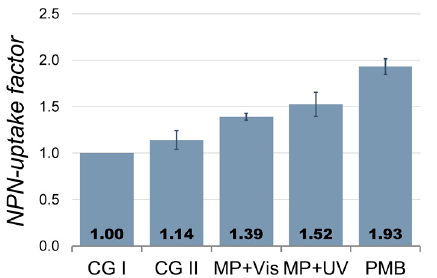
Figure 7. Effects of light and C-TiO 2 +Ni MP powder on S. Typhimurium outer membrane permeability. Two control groups represent data for S. Typhimurium bacteria which were maintained in the dark without (CG I) and with (CG II) C-TiO 2 +Ni MP powder, respectively. MP+Vis and MP+UV samples correspondingly show measures obtained with C-TiO 2 +Ni MP powder and Vis or UV light. PMB samples (bacteria treated by polymyxin B) were used as the additional control for fully permeabilized bacteria membranes.